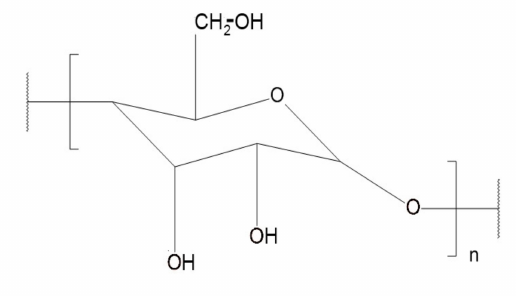
Figure 2. BC chemical